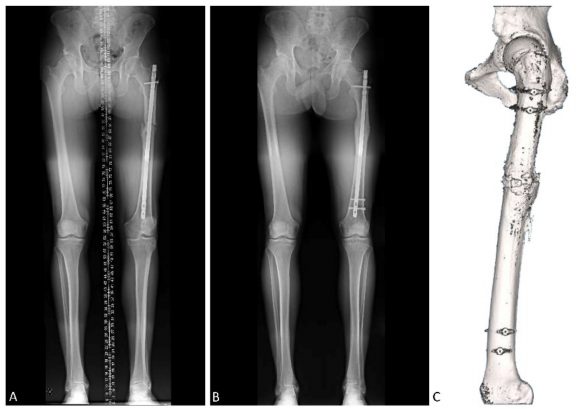
Figure 4. Pre- and postoperative image study (Patient 3). Teleradiographs are conducted to observe rotation before ( A ) and after surgery ( B ). It also indicates callus formation over time. The CT scan also indicates whether the alignment of the femur is correct after surgery ( C